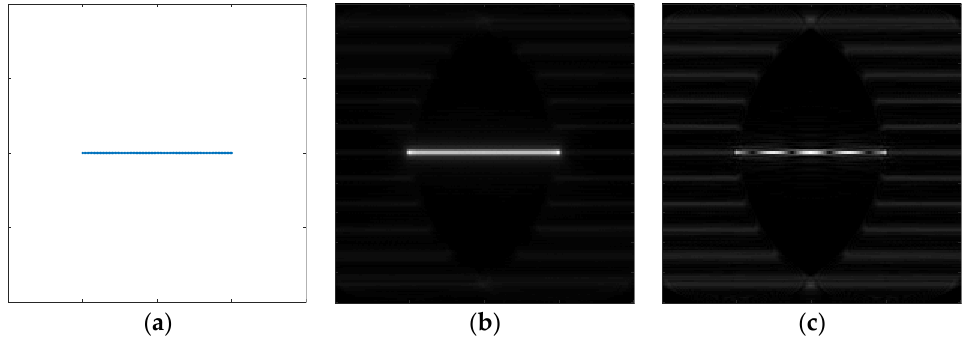
Figure 2. Single line target imaging: ( a ) The target location map; ( b ) the imaging of the traditional backprojection algorithm with a synthetic aperture of 5°; ( c ) The full aperture imaging of the traditional backprojection algorithm.